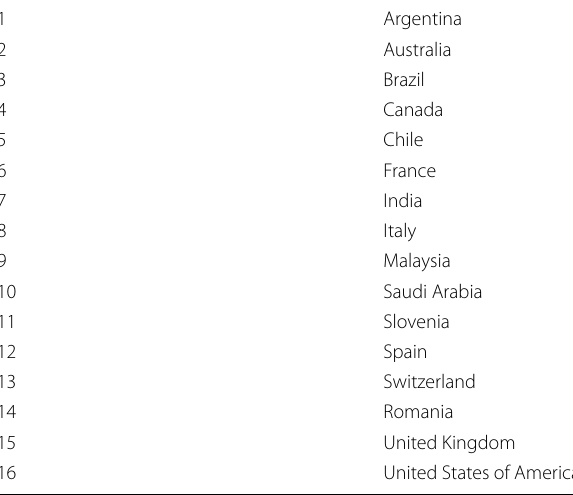
Table 2 Countries represented on the voting